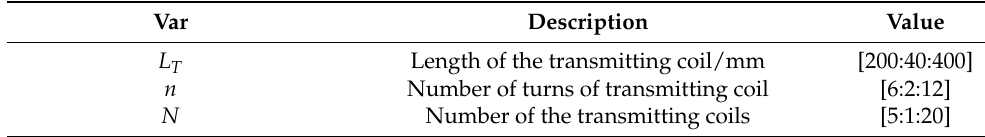
Table 2. Design physical variables and value range.